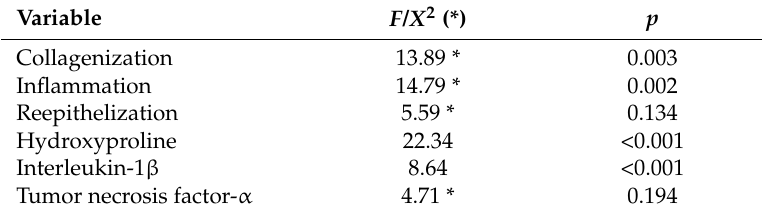
Table 3. Statistical differences of the histopathological and biochemical findings among the groups.